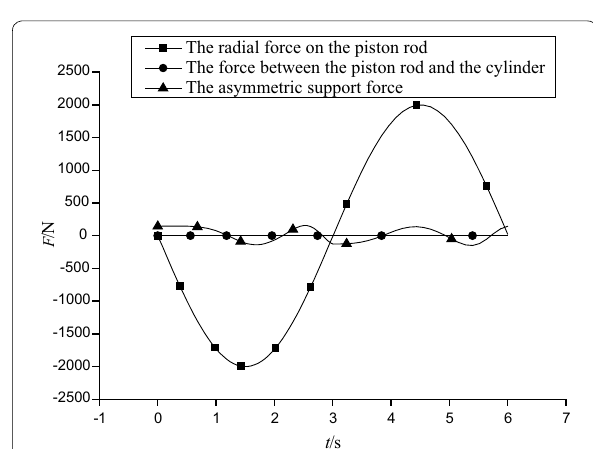
Figure 9 Schematic of piston rod return motion simulation